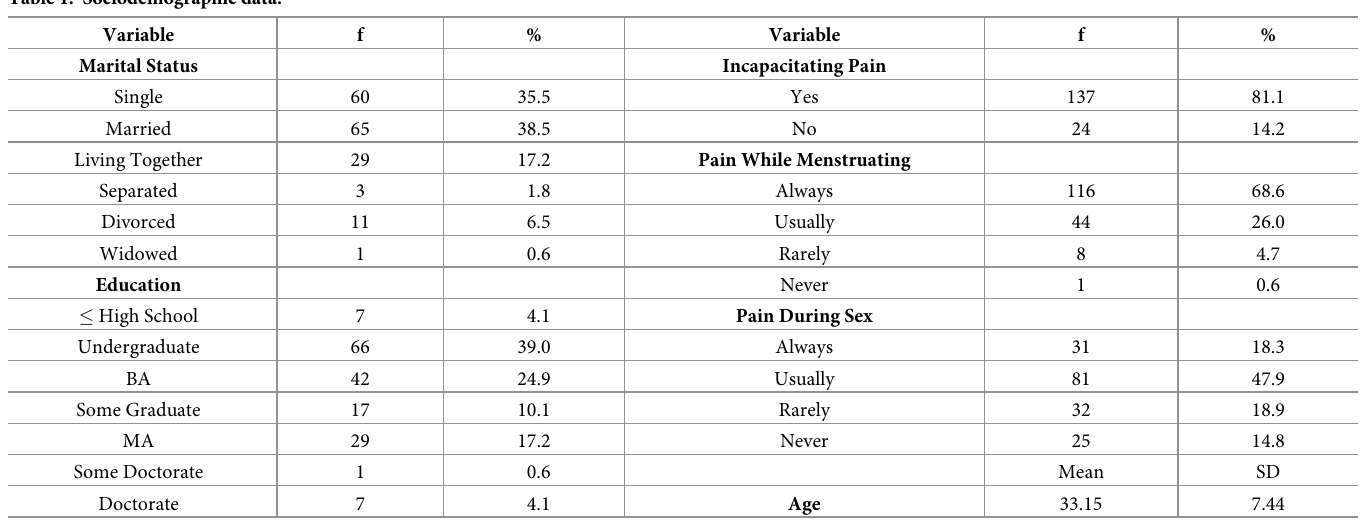
Table 1. Sociodemographic